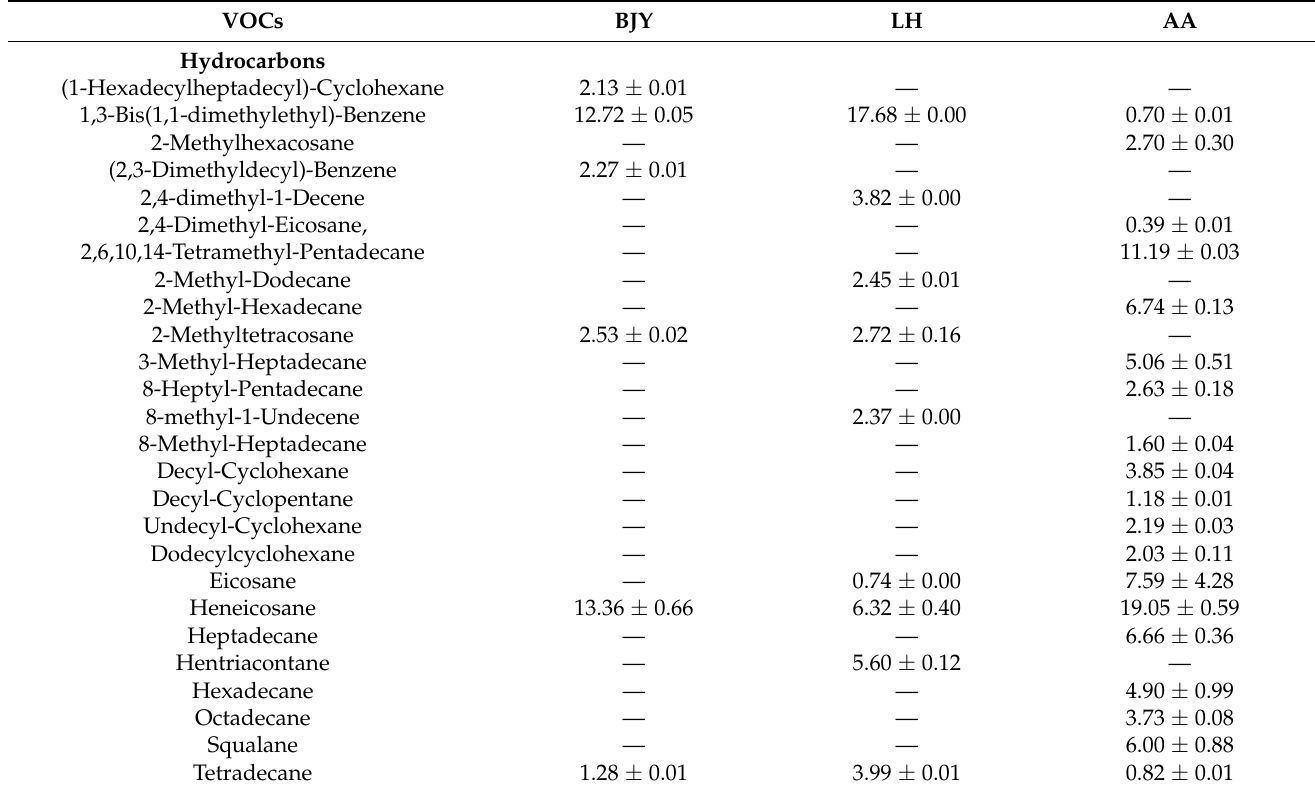
Table 5. Comparison of VOCs relevant contents of different types of chicken breast